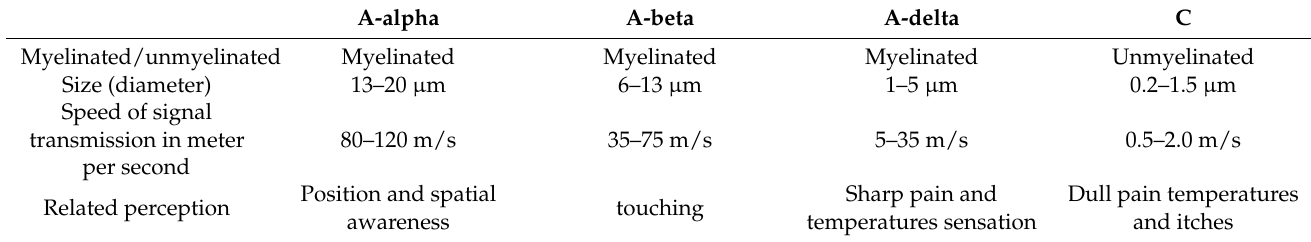
Table 1. Different kinds of nerve